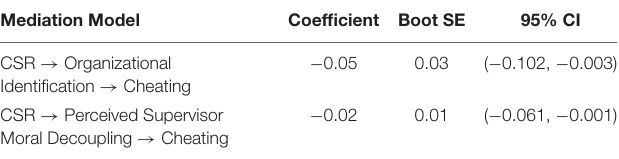
TABLE 5 | Bootstrapping results of the moderated mediation